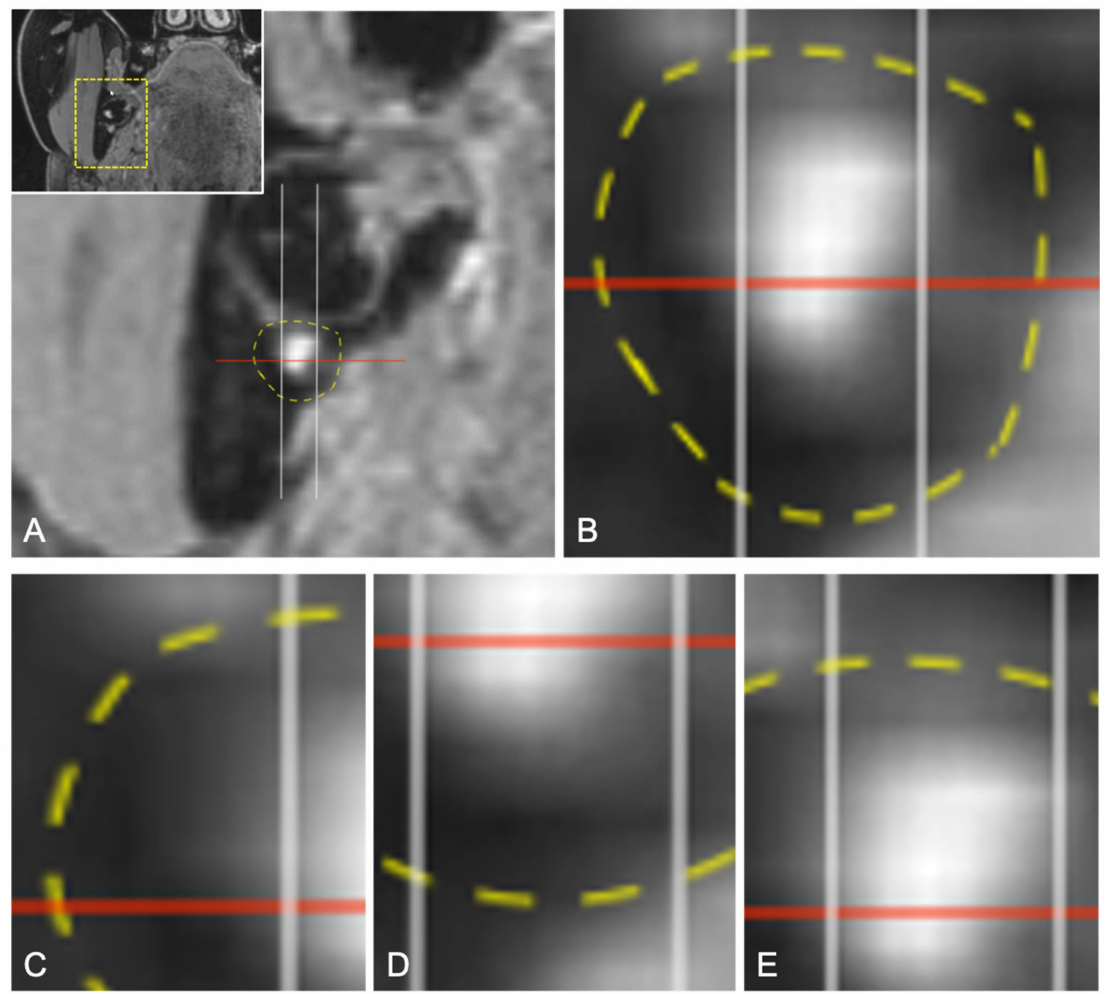
Figure 2. ( A ) Enlarged coronal reconstruction of the 3D-DESS images showing the mandibular third molar and the IAN (MRI signal hyperintensities) with its diameter (red line) located within the IAC (yellow line). ( B ) Enlargement of the evaluation. ( C ) If no part of the segment contains MRI signal hyperintensities of the IAN, it is considered non-visible. ( D ) If less than half to none of the segment’s volume is filled with MRI signal hyperintensities, it is considered non-visible. ( E ) If half or more than half of the segment’s volume is filled with MRI signal hyperintensities of the IAN, it is considered